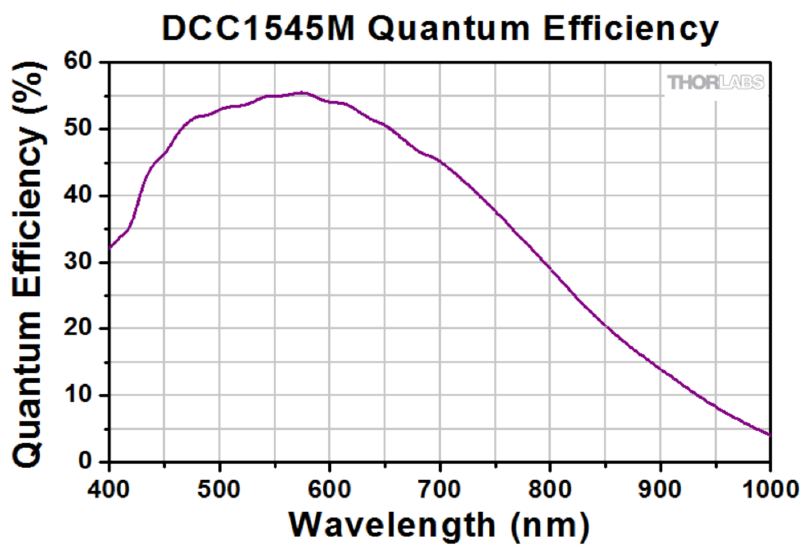
Figure 4. Quantum efficiency of the DCC1545M CMOS